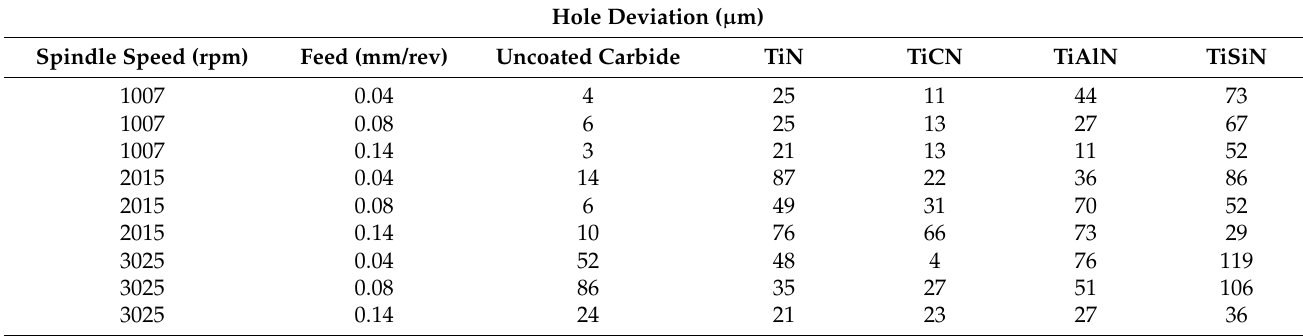
Table 3. Hole deviation from nominal size for the uncoated and coated carbide drills.